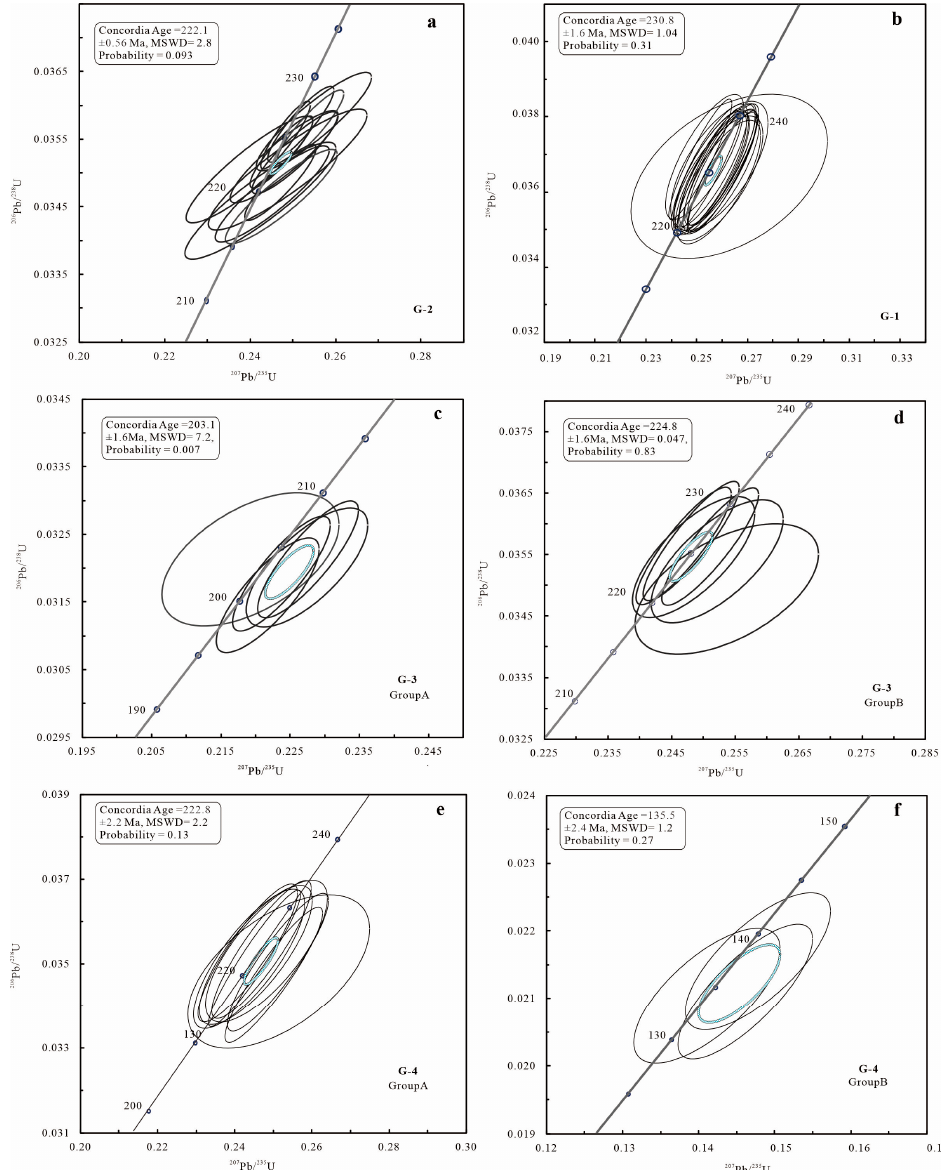
Figure 8. The zircon concordance diagrams of granitoids from Chuankou ore field. ( a ) G-2; ( b ) G-1; ( c , d ) G-3, ( e , f ) G-4.